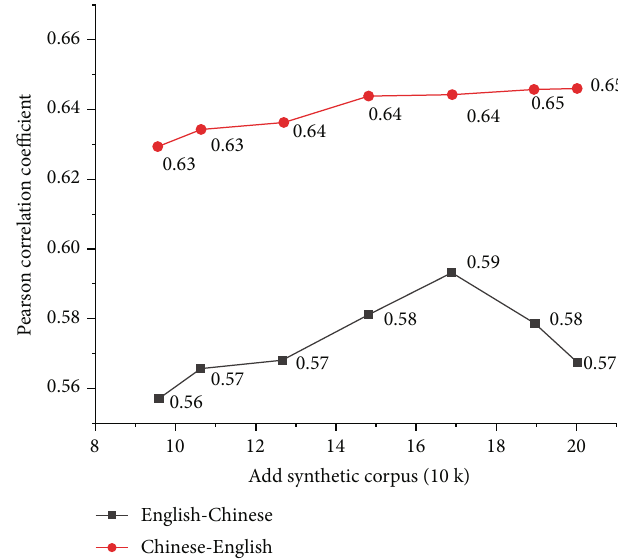
Figure 8: Add (syn-zh) synthetic corpus experimental